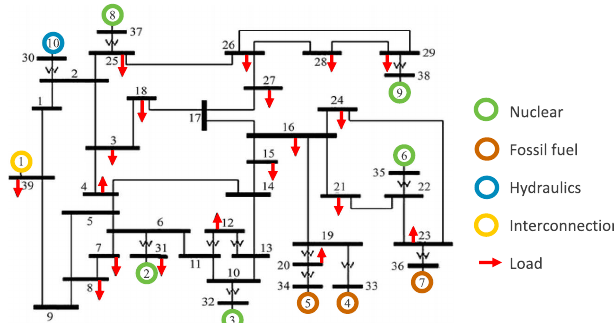
Fig. 1. Representation of the 39-bus grid with all generators surrounded by colour circles